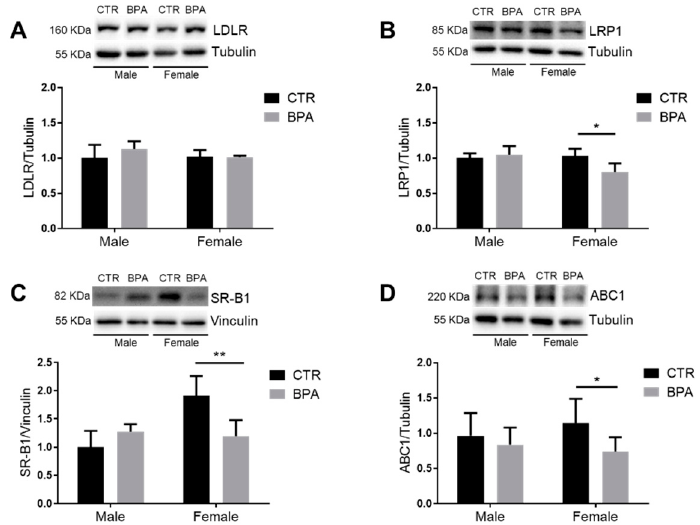
Figure 5. Effects of prenatal exposition to 2.5 µg/kg/day of BPA on cellular lipid import and export in fetal livers of male and female rats. The figure represents a typical Western blot and densitometric analysis of LDLR ( A ), LRP1 ( B ), SR-B1 ( C ), and ABC1 ( D ). Tubulin and vinculin were used to normalize protein loading. Values are expressed as mean ± SD, n = 6 for each experimental group. Differences between groups were considered as significant at p < 0.05 and were analyzed with two-way ANOVA, followed by Tukey post hoc test. * p < 0.5; ** p < 0.01 vs. CTR female.